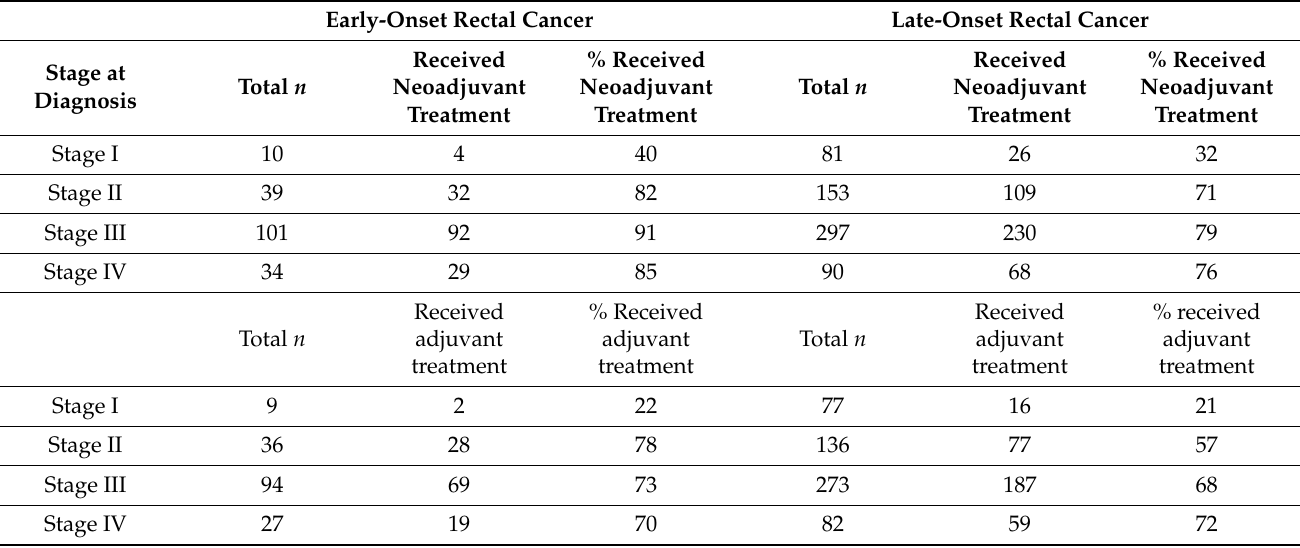
Table 4. Proportion of early- and late-onset rectal cancer patients receiving neoadjuvant and adjuvant treatment by stage at diagnosis (i.e., before the receipt of any neoadjuvant